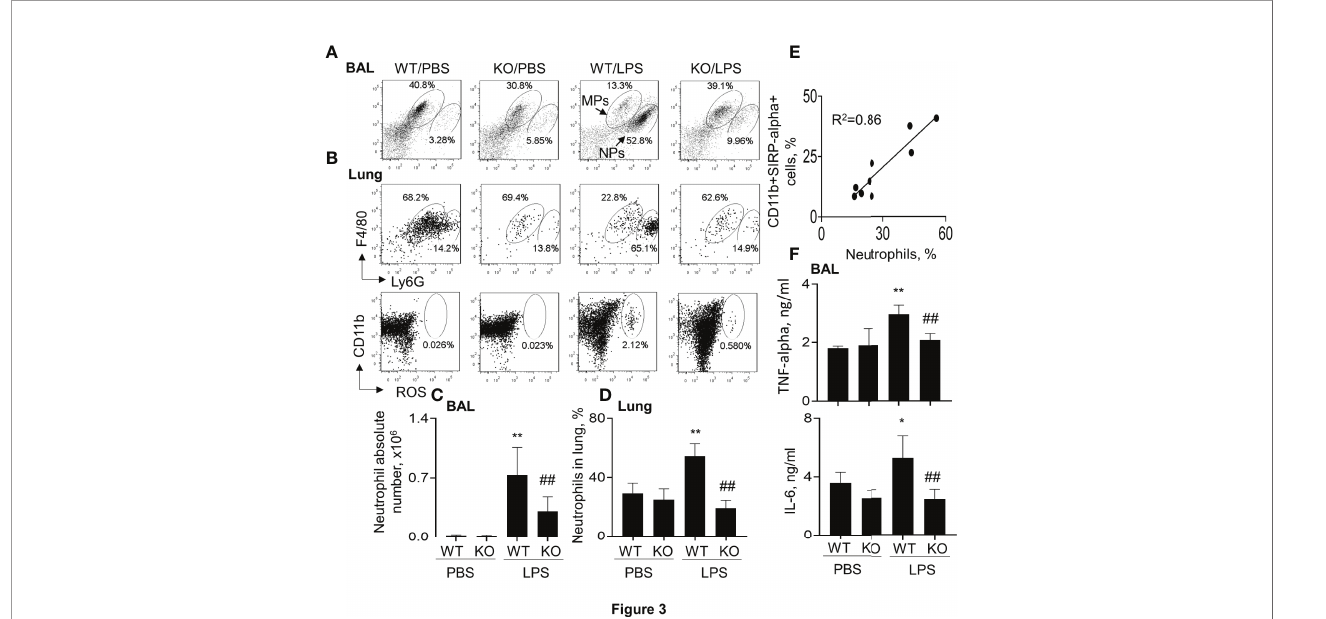
FIGURE 3 | Lack of SIRP-alpha reduced neutrophil in fi ltration and expression of pro-in fl ammatory cytokines in murine ALI. (A) Flow cytometry analysis for the in fi ltrating neutrophils (NPs) and macrophages (MPs) in BAL (A) and lung digests (B, upper panel). NPs were identi fi ed as F4/80(low)Ly6G(high) cells; MPs were identi fi ed as F4/80 (high) Ly6G (low) cells. Cell mitochondria-derived reactive oxygen species (ROS) was analyzed by respiratory burst assay kit (B) , lower panel). Representative dot plot. (C, D) Quantitative analysis of neutrophil absolute number in BAL and the percentage of NPs in lung tissues. (E) Correlation analysis between the percentage of NPs and SIRP-alpha expression in the lung digests. Each point presents individual sample. (F) ELISA analysis for the expression of TNF- alpha and IL-6 in BAL. All quantitative data was presented as mean ± standard deviation, *p < 0.05, **p < 0.01 vs. PBS group; ## p < 0.01 vs. WT group, n=5-6. One-way ANOVA followed by Tukey ’ s multiple comparisons test.